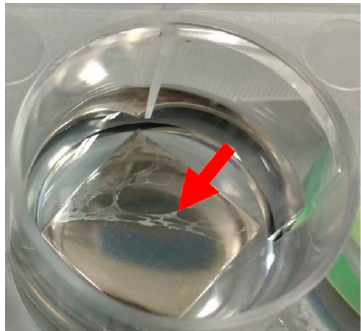
Figure 5. A cell layer peeled off the smooth surface of a polished sample (arrow). This phenomenon was observed on all samples with roughness below 25 nm, i.e., GL, PL, and DLC, but it was most noticeable on PL. These samples were excluded from the